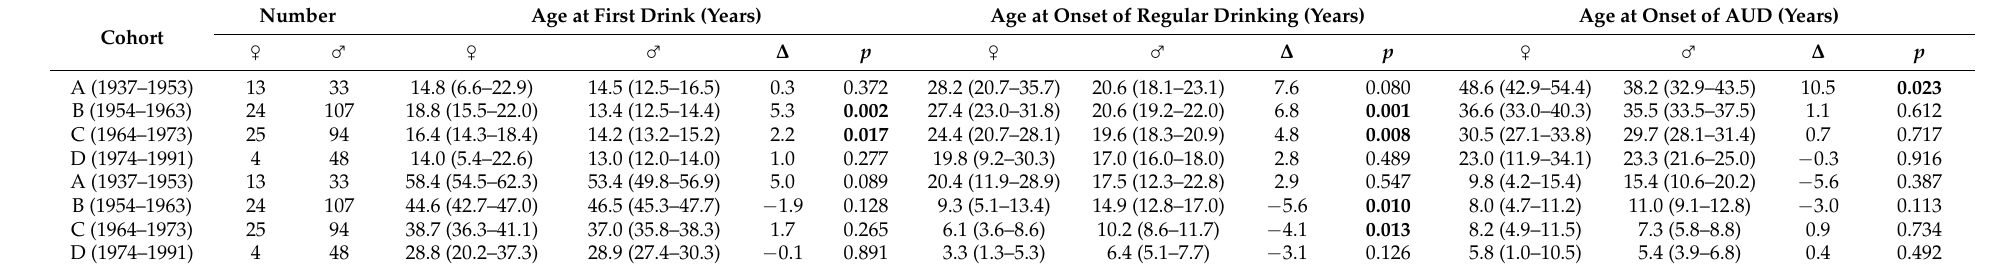
Table 2. Gender differences and similarities in drinking characteristics of a sample of Sardinian AUD patients divided in birth cohorts.